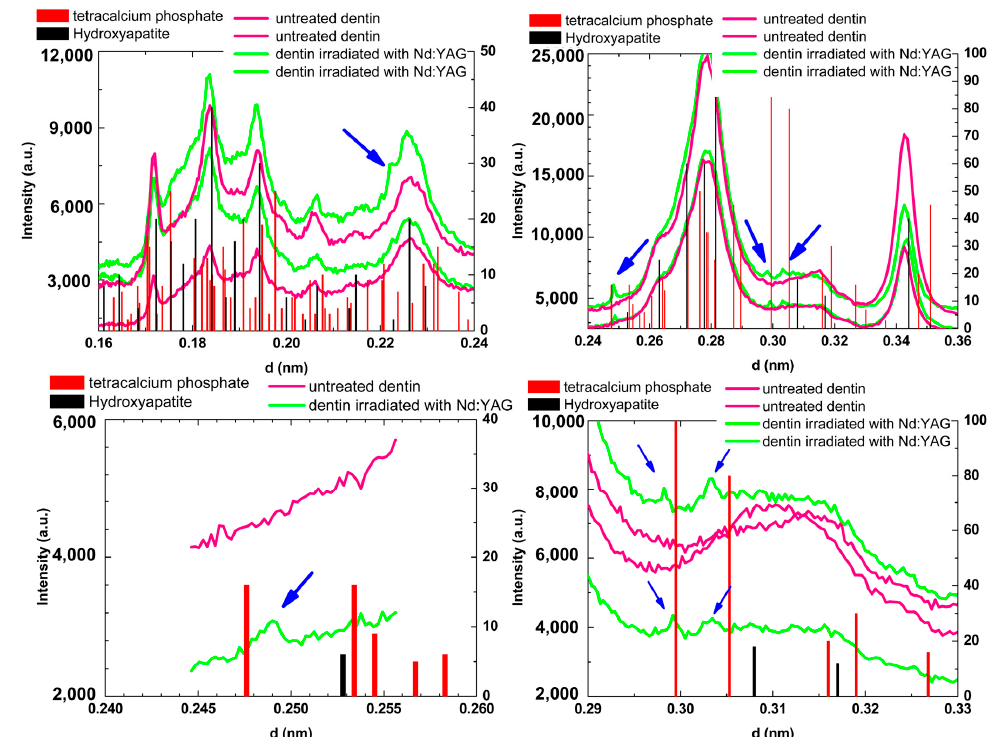
Figure 4. Experimental X-ray diffraction patterns of the untreated dentin, laser irradiated dentin samples, and the expected patterns for hydroxyapatite (HAP, JCPDF 09-0432) and for tetracalcium phosphate (TetCP, JCPDF 25-1137). The blue arrows indicate additional peaks on irradiated dentin that are close to peaks of TetCP.